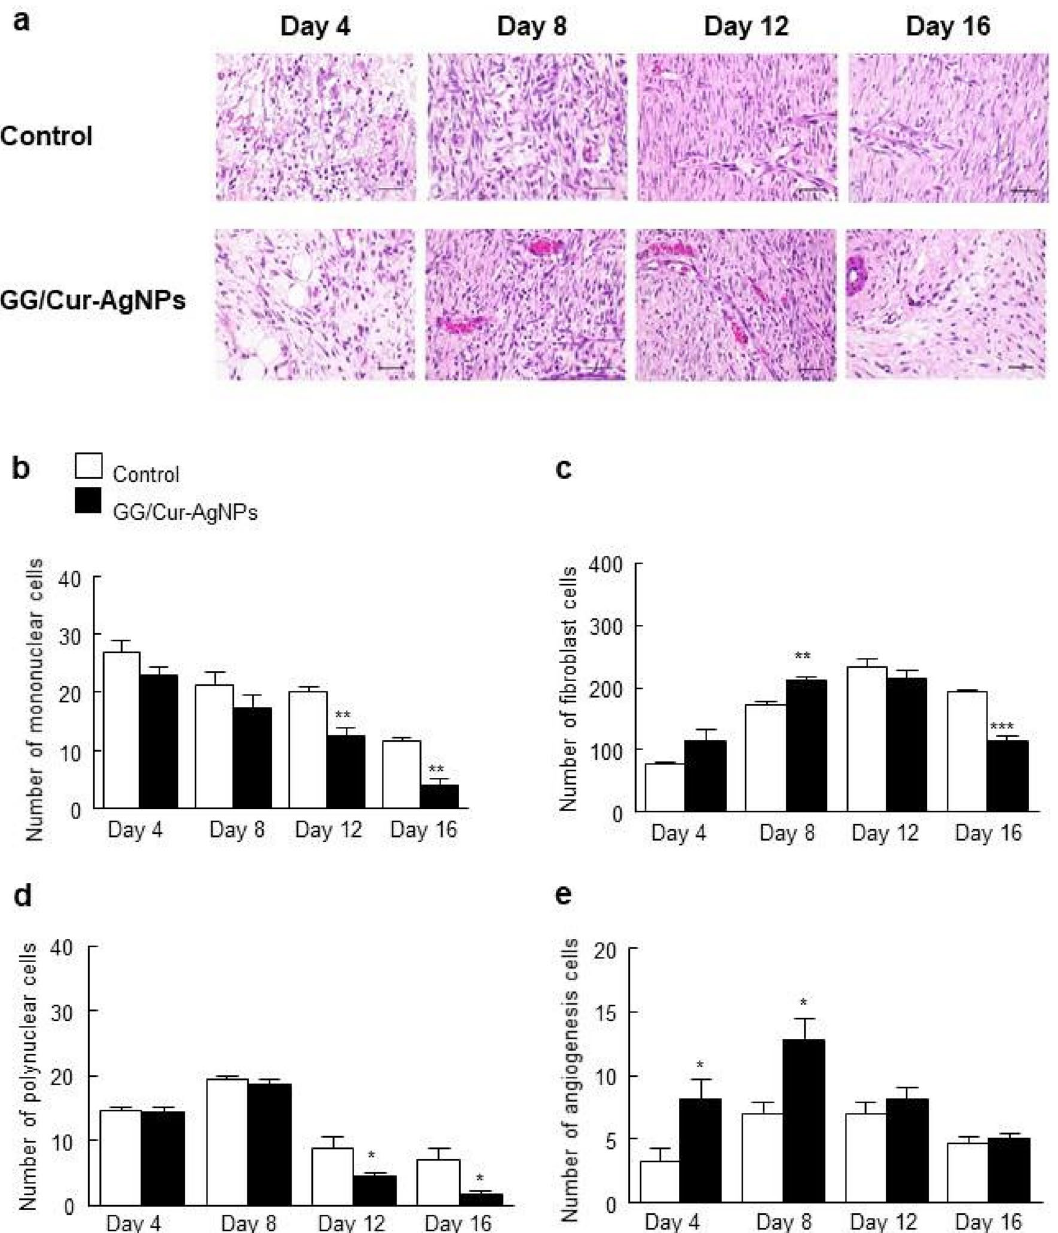
Figure 6. Histopathology of rat skin on day 4, 8, 12 and 16 of the wound incisions stained with hematoxylin & eosin staining. ( a ) Micrographs of sections of wound incision rat skin under treatment with commercial antibacterial gels (control) and GG/Cur-AgNPs. Hematoxylin (deep blue-purple) stains nucleic acids/nuclei, eosin (pink) stains proteins non-specifically indicating the cytoplasm and extracellular matrix. ( b ) Number of mononuclear leukocytes. ( c ) polymorphonuclear leukocytes. ( d ) fibroblasts. ( e ) capillaries were counted in 10 high-power field (HPF) (400 × magnification). Data were expressed as mean ± SEM ( n = 3/time point). * P < 0.05, ** P < 0.01 and * P < 0.001 compared to the control on day of experiments. Scale bar = 40